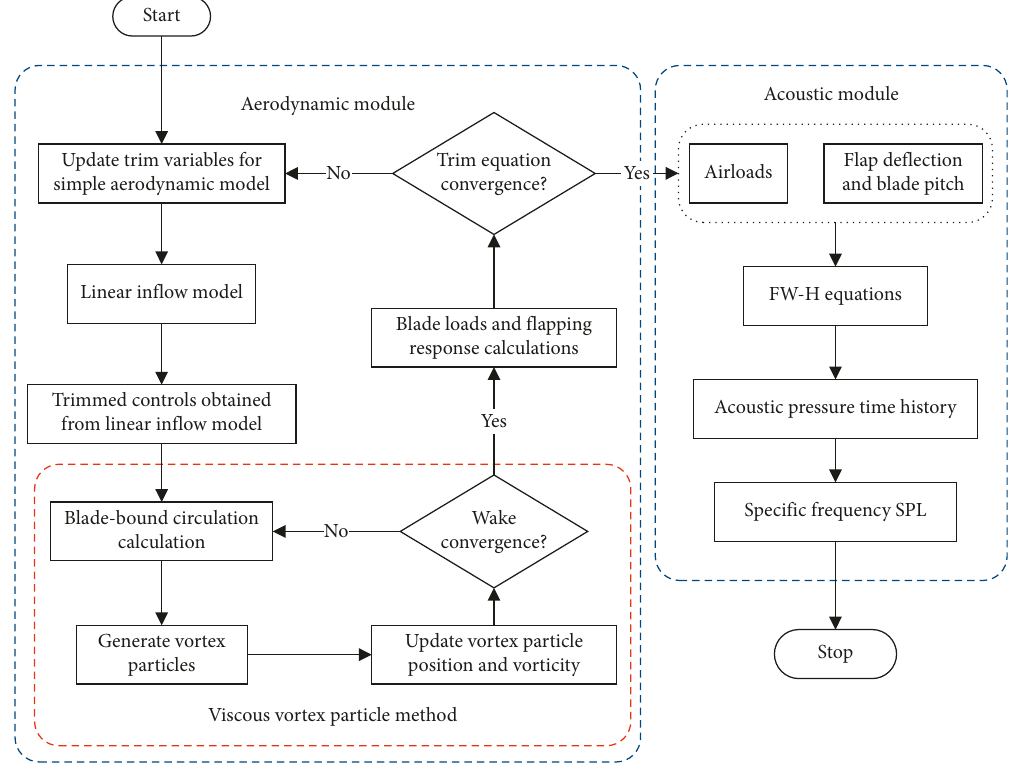
Figure 2: Schematic flowchart of BVI airloads and noise prediction of ECR.